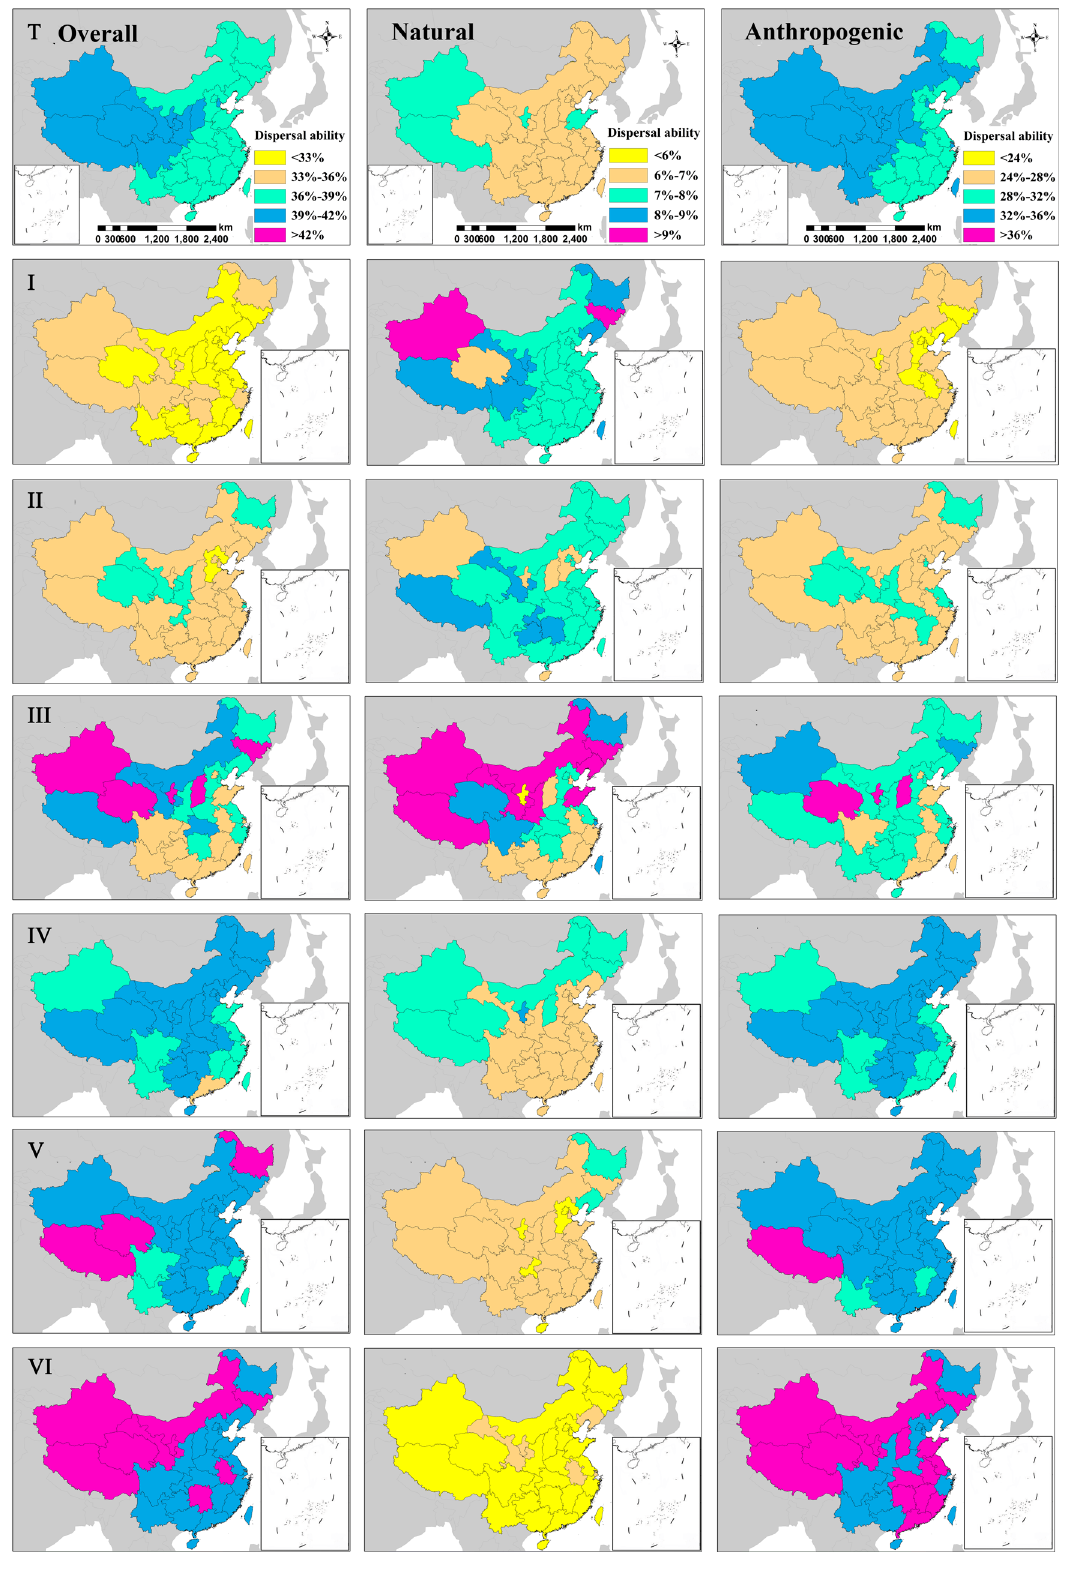
Figure 3. Geographical distribution of dispersal ability of all species studied and six risk ranks ( I – VI ) for the overall, natural, and anthropogenic dispersal abilities across China. (T) Total alien plant species; ( I ) rank I: malignant invaders; ( II ) rank II: serious invaders; ( III ) rank III; local invaders; ( IV ) rank IV; mild invaders; ( V ) rank V; species requiring further observation; ( VI ) rank VI: cultivated alien species. Maps generated by ArcMap 10.0 (https:// suppo rt. esri. com/ zh- cn/ Produ cts/ Deskt op/ arcgis- deskt op/ arcmap/